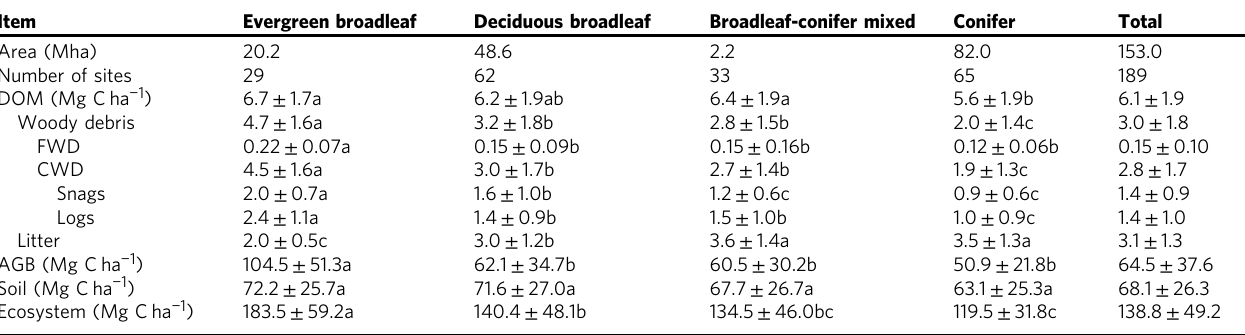
ranged from 2.0 to 16.2 Mg C ha − 1 (1 Mg = 10 6 g) with an